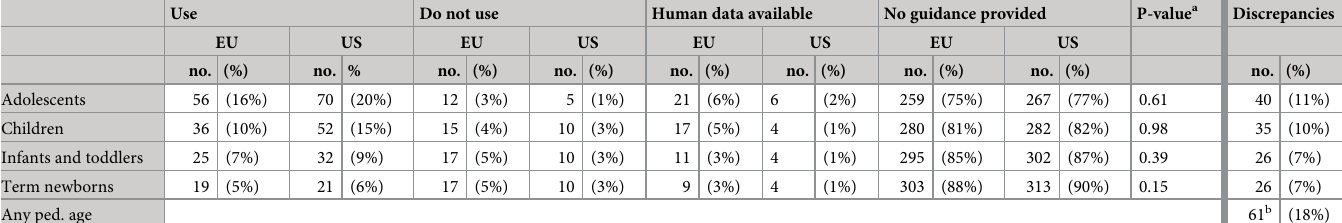
Table 4. Level of guidance for pediatric use for indications in the EU and the US per age group (percentages calculated from the total number of indications, n = 348).